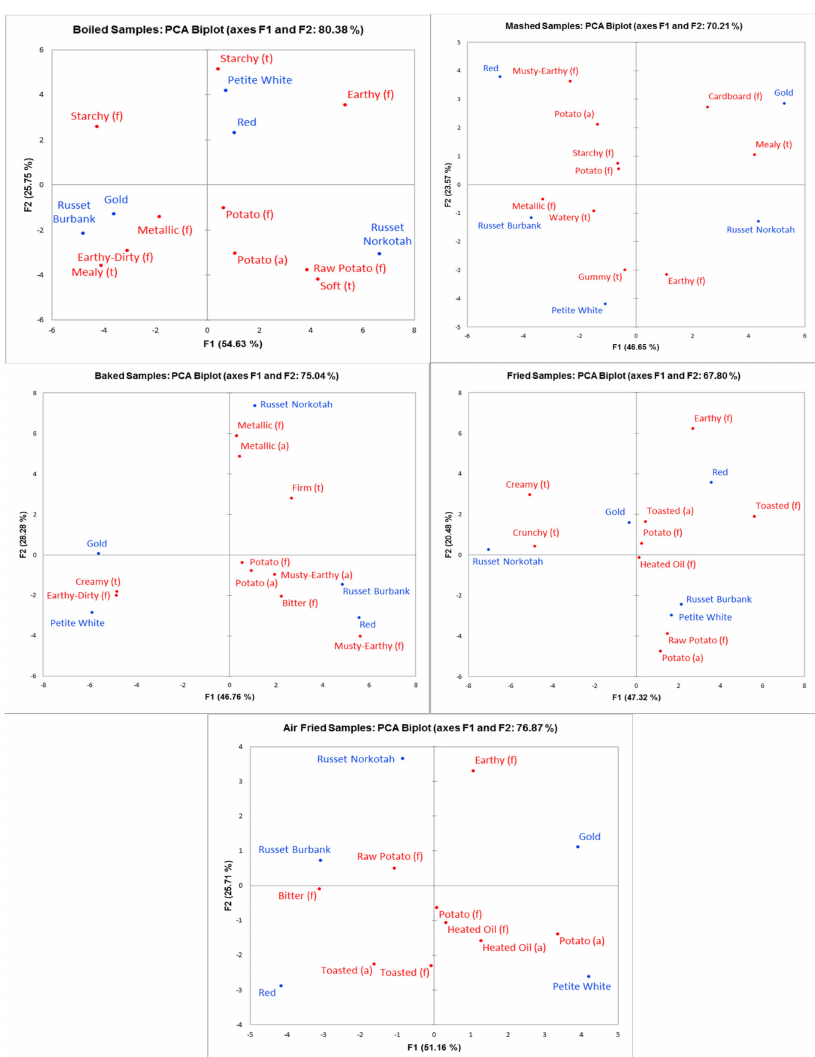
Figure 6. Principal component analyses (PCA) by cooking method of aroma (a), flavor (f), and texture (t) HITs for all potato varieties.